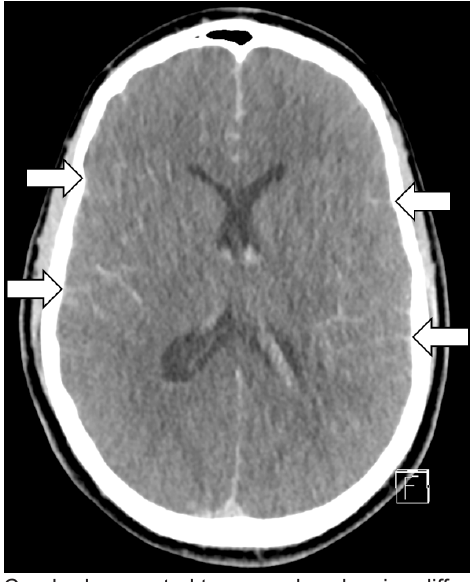
Image 2. Cerebral computed tomography, showing diffuse subarachnoid hemorrhage with generalized cerebral